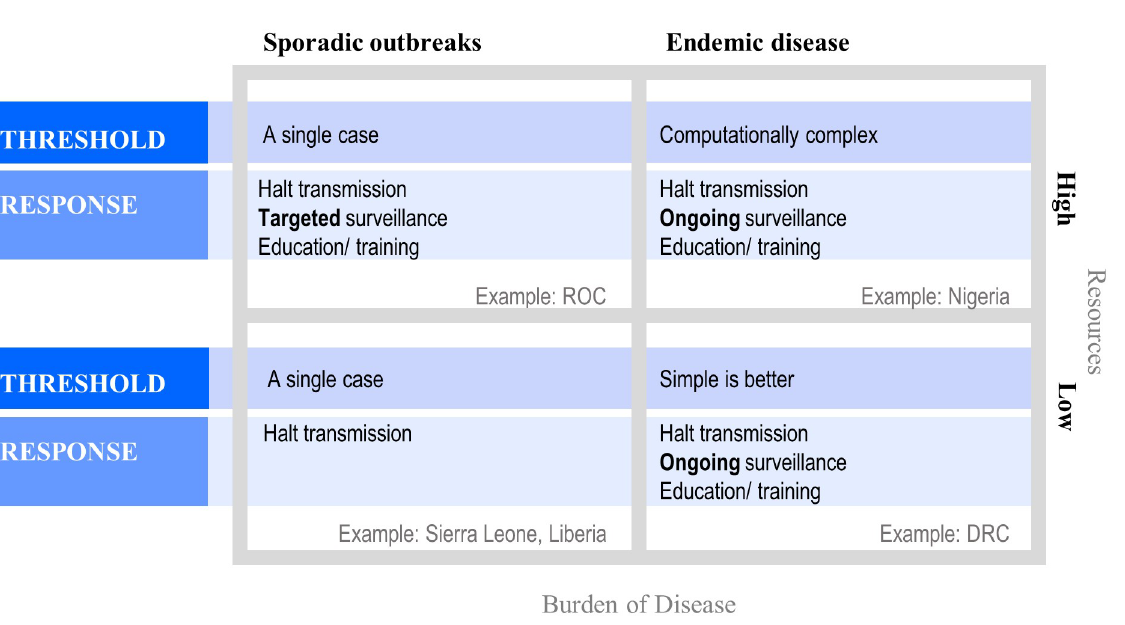
PLOS NeglectedTropical Diseases | https://doi.org/10.1371/journal.pntd.0007034 December20,